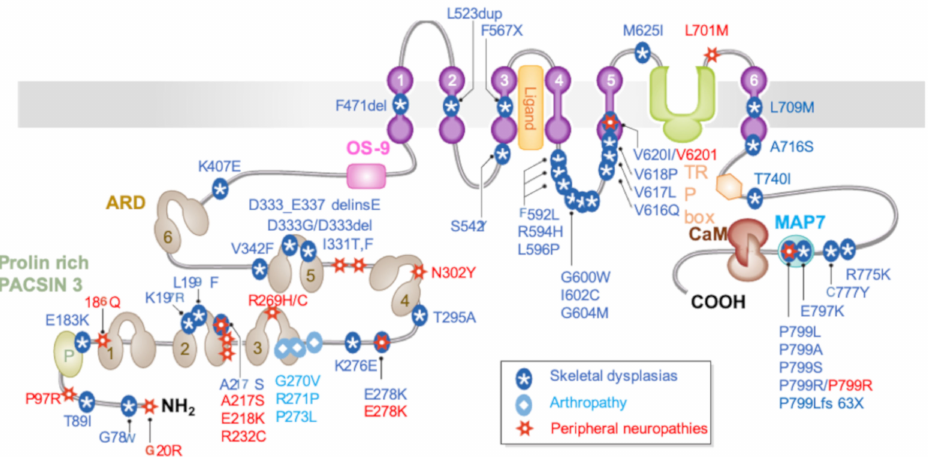
Figure 3. Structure of TRPV4, with putative functional domains and disease-causing mutations. From (6) with